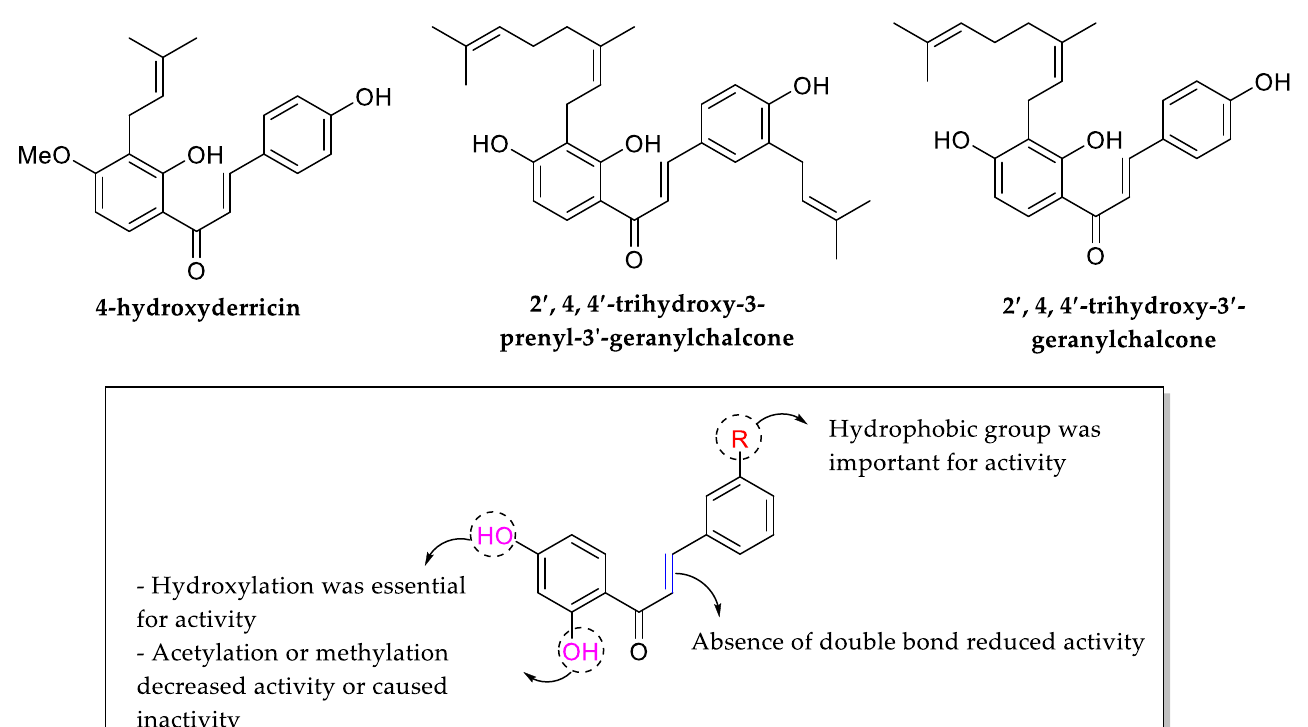
Figure 10. Chemical structures of several tested chalcones and SAR of chalcones for antibacterial activity